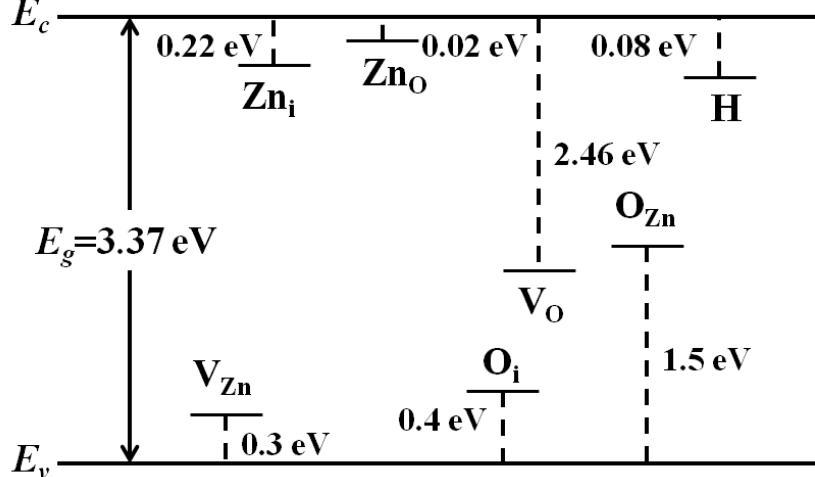
Figure 1. The energy levels diagram of lattice defects in intrinsic ZnO semiconductors [16].